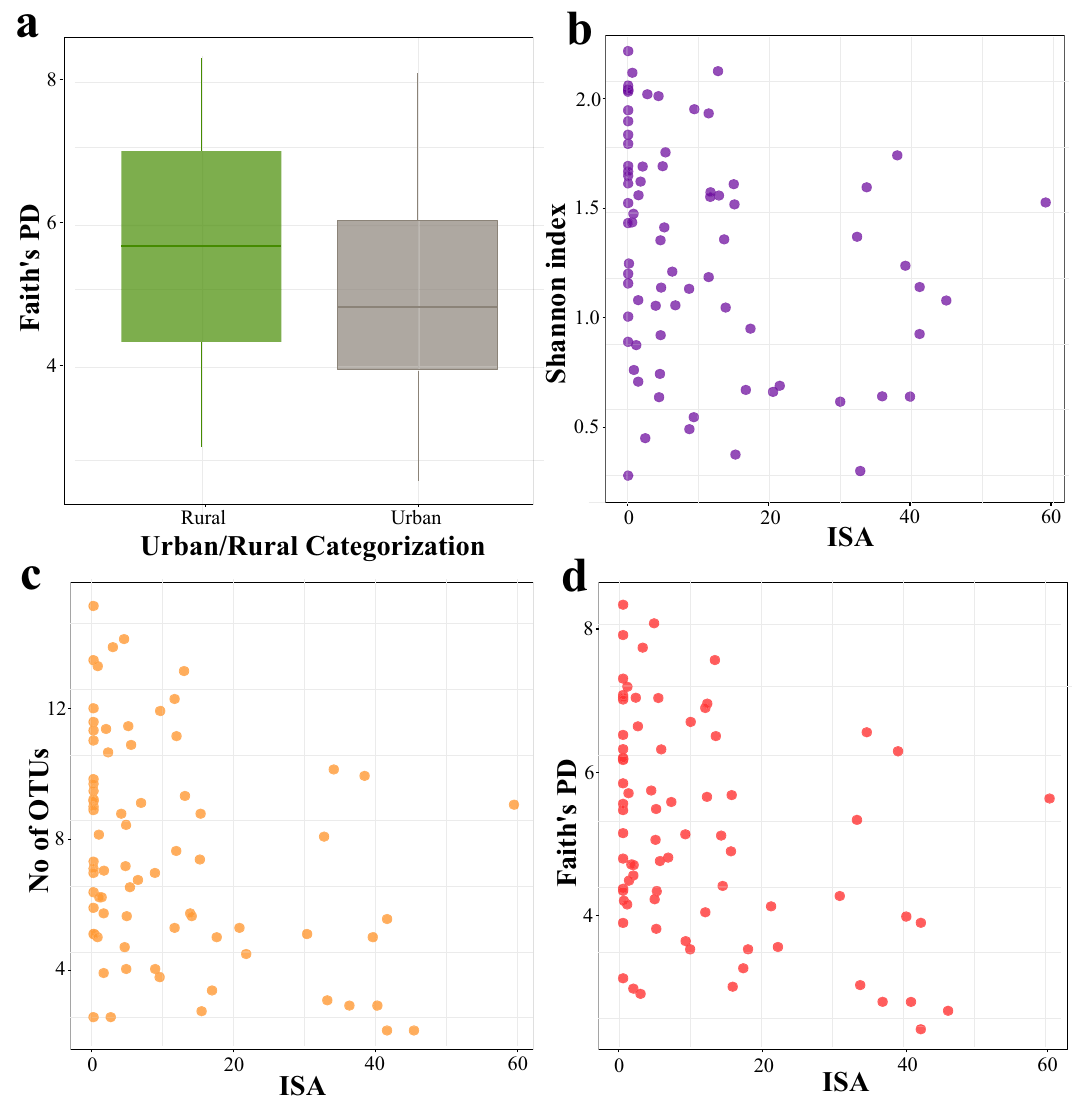
Figure 4. Alpha diversity across the urban mosaic. ( a ) Boxplot of Faith’s phylogenetic diversity of nestlings originating from urban and rural sites. Scatter plots report the relationship between ISA and ( b ) Shannon’s diversity index ( c ) The number of observed OTUs, and ( d ) Faith’s phylogenetic diversity. The figure was generated in R version 4.0.0 68